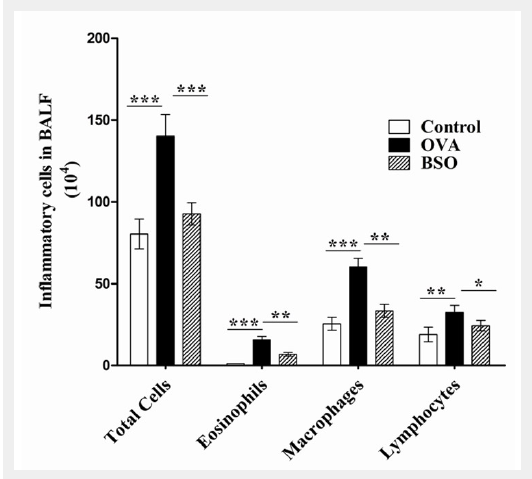
BSO inhibited the recruitment of inflammatory cells in BAL fluid of E3 rats. Rats were divided into 3 groups; Control (immunised and challenged with PBS), OVA (immunised and challenged with OVA) and BSO (immunised and challenged with PBS, and treated with 4 ml/kg of BSO groups). The results were expressed as the means ± S.E.M. for 10 rats in each group. *p <0.05 and **p <0.01, ***p <0.001 were considered statistically significant differences between the control group and OVA group or between the OVA group and BSO group.